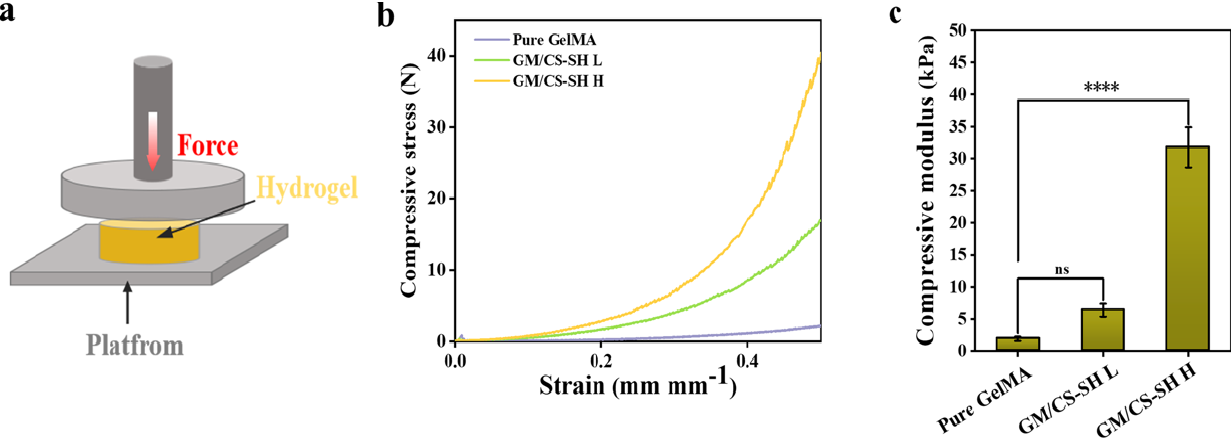
Figure 3. The mechanical property of GM/CS-SH hydrogels. ( a ) Schematic illustration of compressive test. ( b ) Stress/strain curves of hydrogels. ( c ) The compressive modulus of hydrogels. (Statistical significance was calculated via one-way ANOVA using Bonferroni’s post hoc test. ns: no statistical difference, **** p < 0.0001.) All data are presented as mean ± SD.